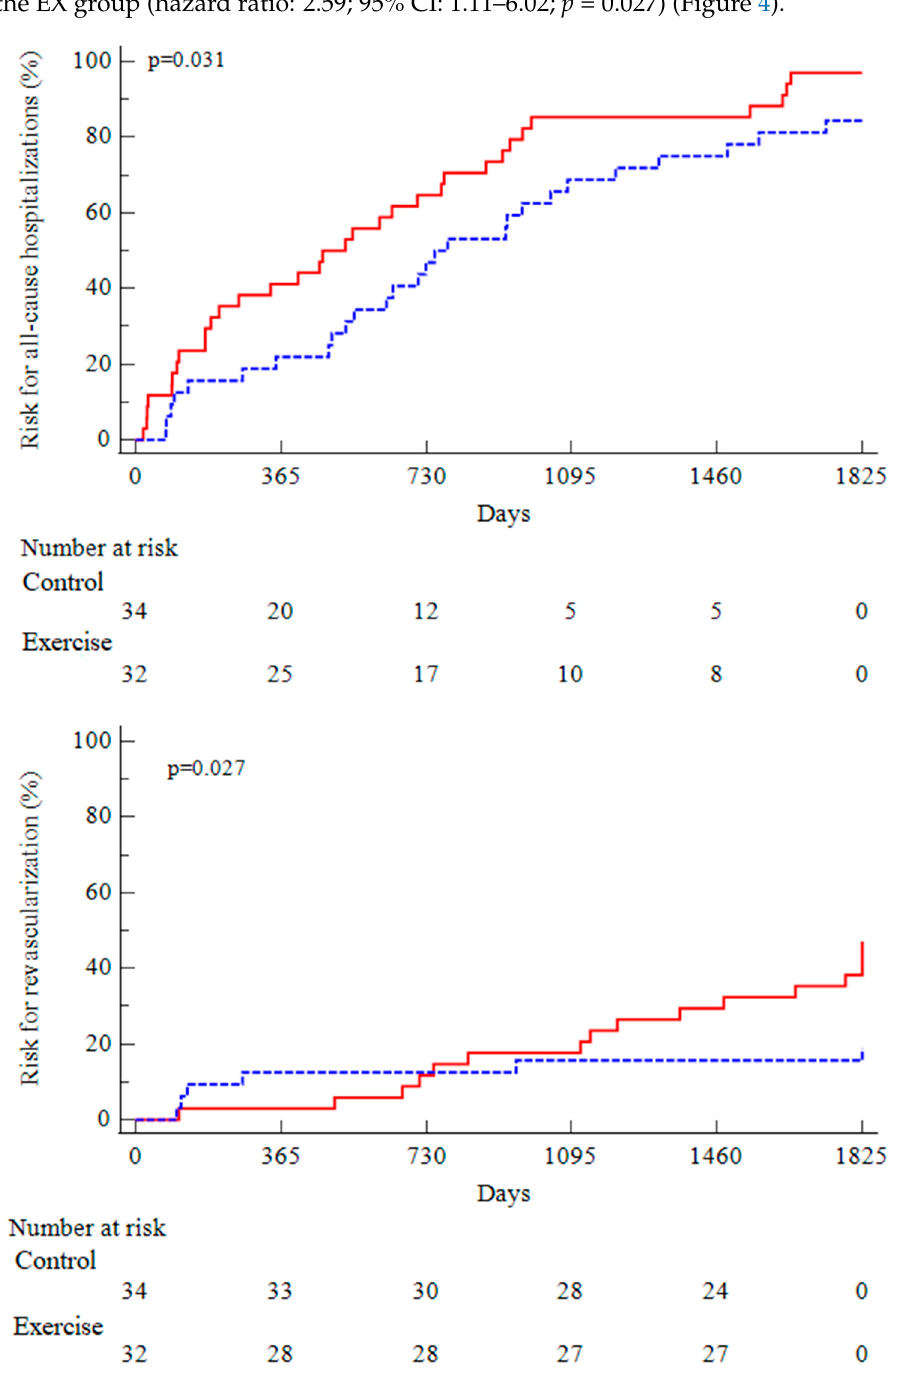
Figure 4. Kaplan ‒ Meier curves of all-cause hospitalizations and peripheral revascularizations in the two groups (blue, exercise; red,